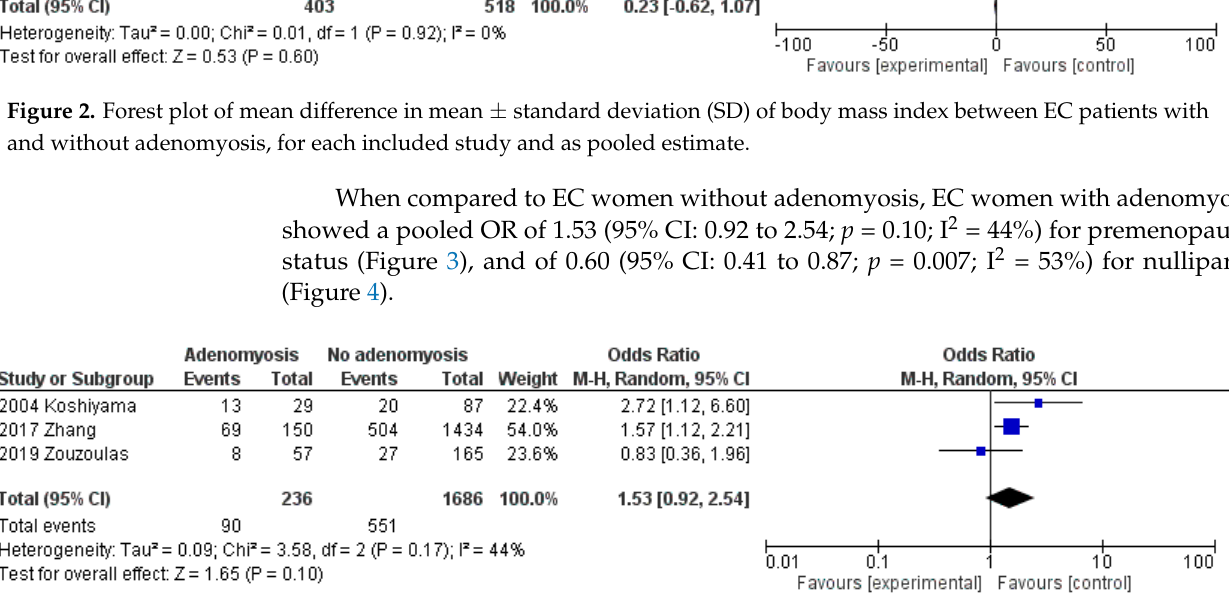
Figure 3. Forest plot of odds ratio for premenopausal status in endometrial cancer patients with adenomyosis compared to endometrial cancer patients without adenomyosis, for each included study and as pooled estimate.